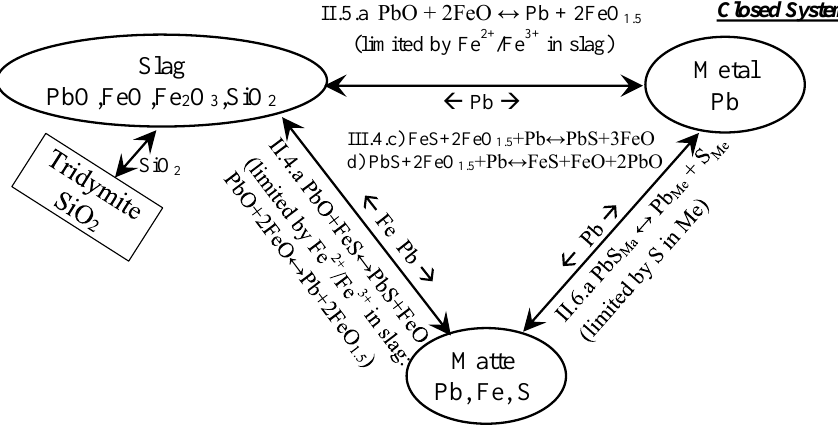
Figure 4. Schematic inter-phase mass transfer diagram of the key mass transfer of elements between phases and reactions, expected to be important in the closed system.